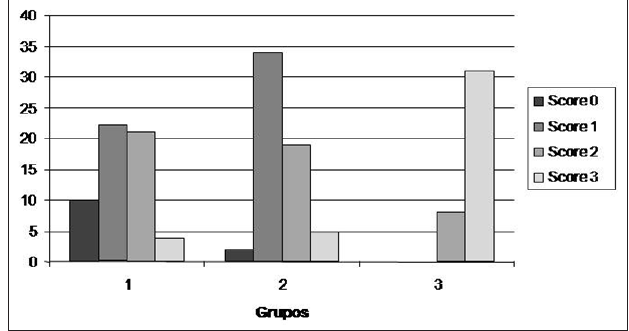
Fig. 1 – Number of scores attributed to each